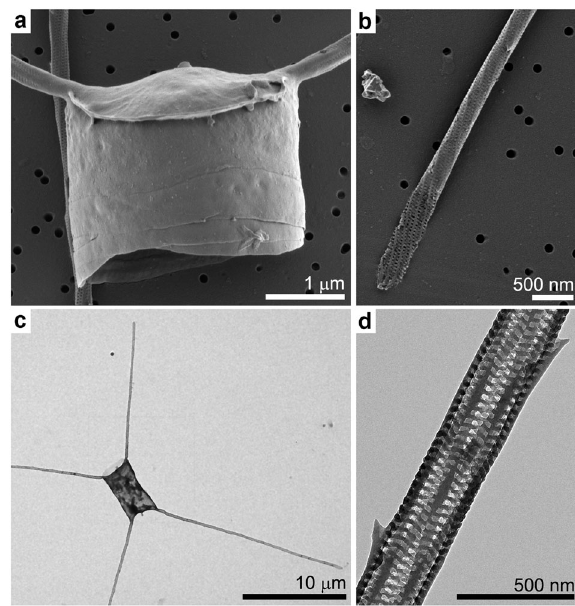
Fig. 1 The silica cell wall morphology of C. tenuissimus . a , b Scanning electron microscopy (SEM) images of cells dried on a support membrane. c , d Transmission electron microscopy (TEM) images of cell walls washed in water and air dried onto a